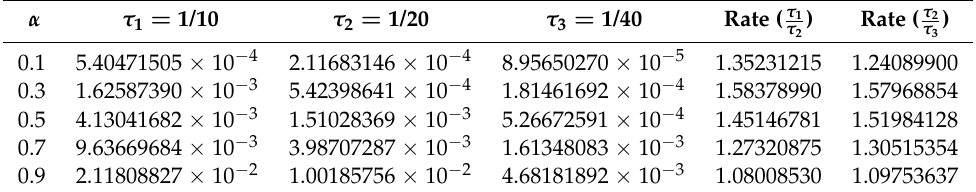
(cid:107) u ( t n ) − u n (cid:107) with h = h n